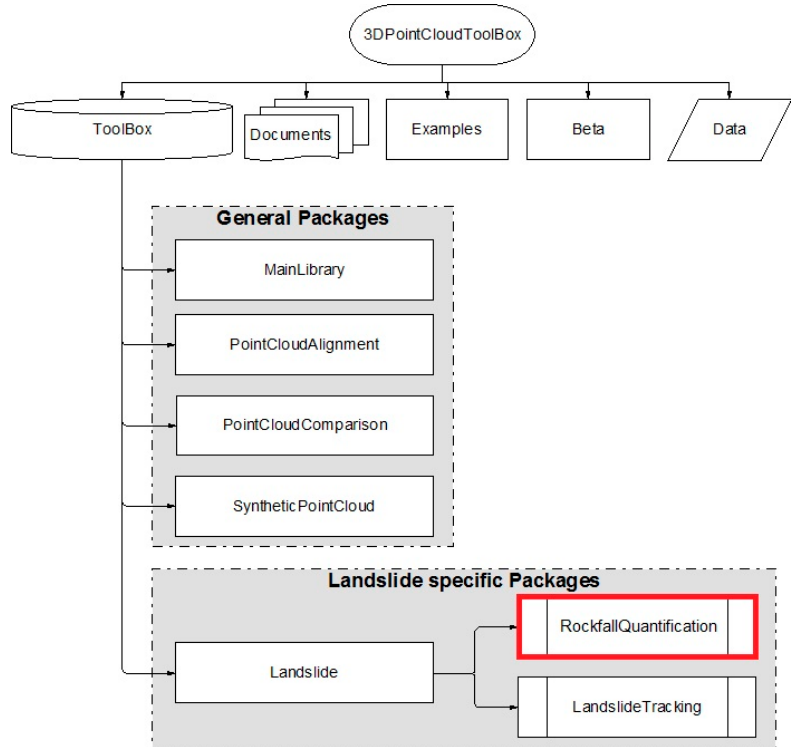
Figure A1 . The structure of the 3DPointCloudToolBox contains folders labeled as Documents for tutorials, Examples of scripts to start up, Beta for functions in development, and Data to store raw data that can be used in the 3DPointCloudToolBox. The main folder Toolbox contains subfolders for point cloud data treatments (MainLibrary, PointCloudAlignment, PointCloudComparison, SyntheticPointCloud) and a specific subfolder landslide for landslide monitoring, with one for rockfall monitoring and another for landslide surface displacement monitoring (RockfallQuantification, LandslideTracking).